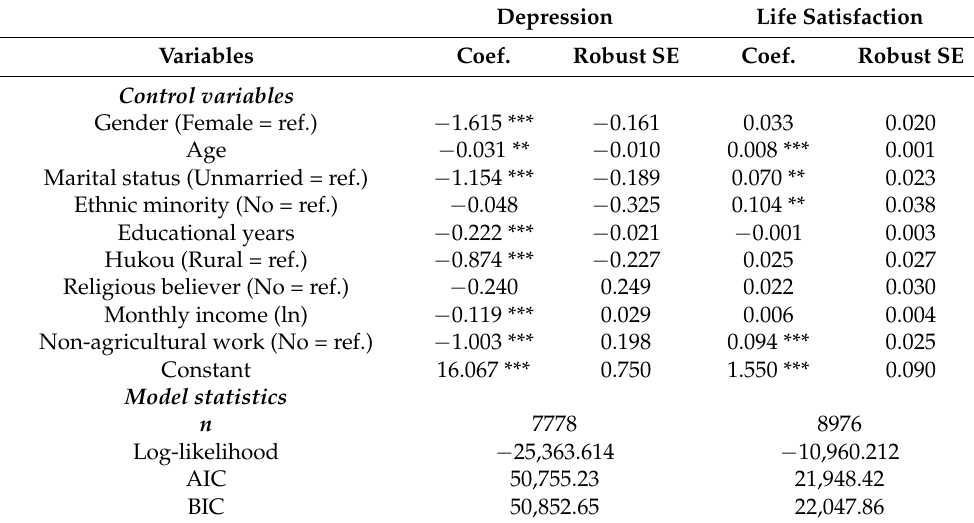
Table 2. Cont. Depression Life Satisfaction Variables Coef. Robust SE Coef. Robust SE Control variables